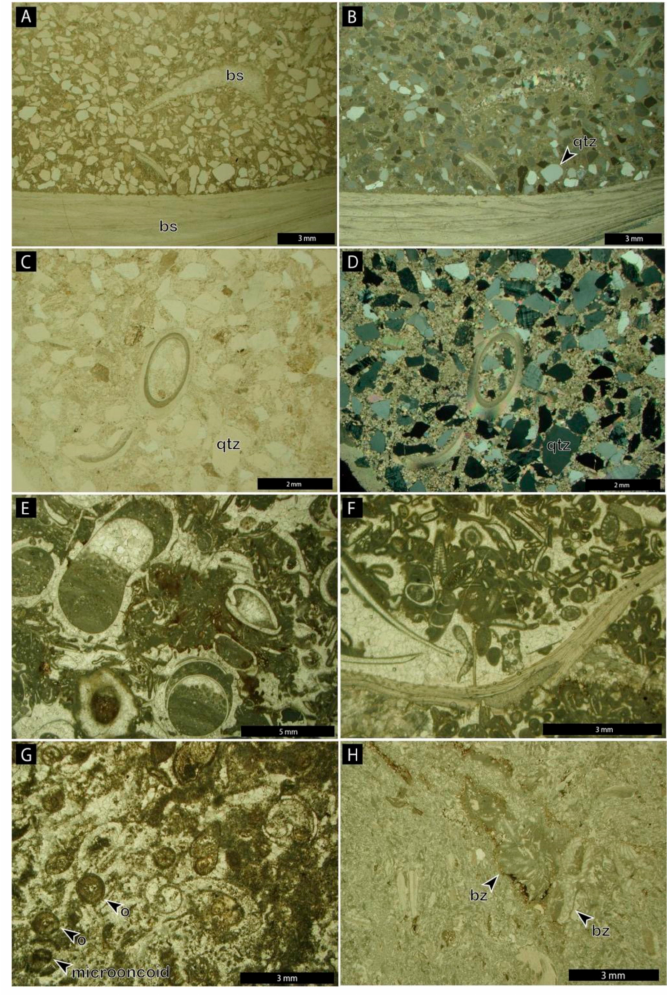
Figure 6. Photomicrographs of limestone and clastic sedimentary rocks in the study section. ( A , B ) Shell bed of the lower sequence of the Gava-1 section (sample number, SB1-02). Very an- gular medium- to coarse-grained quartz (qtz) grains were contained within the fine calcareous muddy matrix. Few bivalve shells (bs) were scattered in the sandstone. ( A ) Under open polarized light and ( B ) under cross-polarized light. ( C , D ) Shell bed of the lower sequence of Karabulak section (sample number, SB1-12). Very angular and poorly sorted medium- to coarse-grained quartz grains were contained within a sparry calcite cement matrix. Some bivalve shells and tube-like fragments were scattered throughout the matrix. A miniscule amount of plagioclase grains was recognized as clastic grains. ( C ) Under open polarized light and ( D ) under cross-polarized light. ( E ) Bioclastic packstone of the upper sequence of the Gava-1 section (sample number, LS2-01). Numerous bioclastic fragments, such as gastropods, bivalves, and foraminifers, were contained within a calcareous muddy matrix. Under open polarized light. ( F ) Oncoids and bioclastic grainstone of the Gava-1 section (sample number, LS1-04). Numerous cortoid particles could be observed. Under open polarized light. ( G ) Microoncoids (indicated with arrows), oolite grains (o), and bioclastic limestone of the upper sequence of Karabulak section. Under open polarized light. ( H ) Bioclastic limestone of Karabulak section (sample number, LS-07). Bivalve shell and fragments of bryozoa (bz) were included. Under open polarized